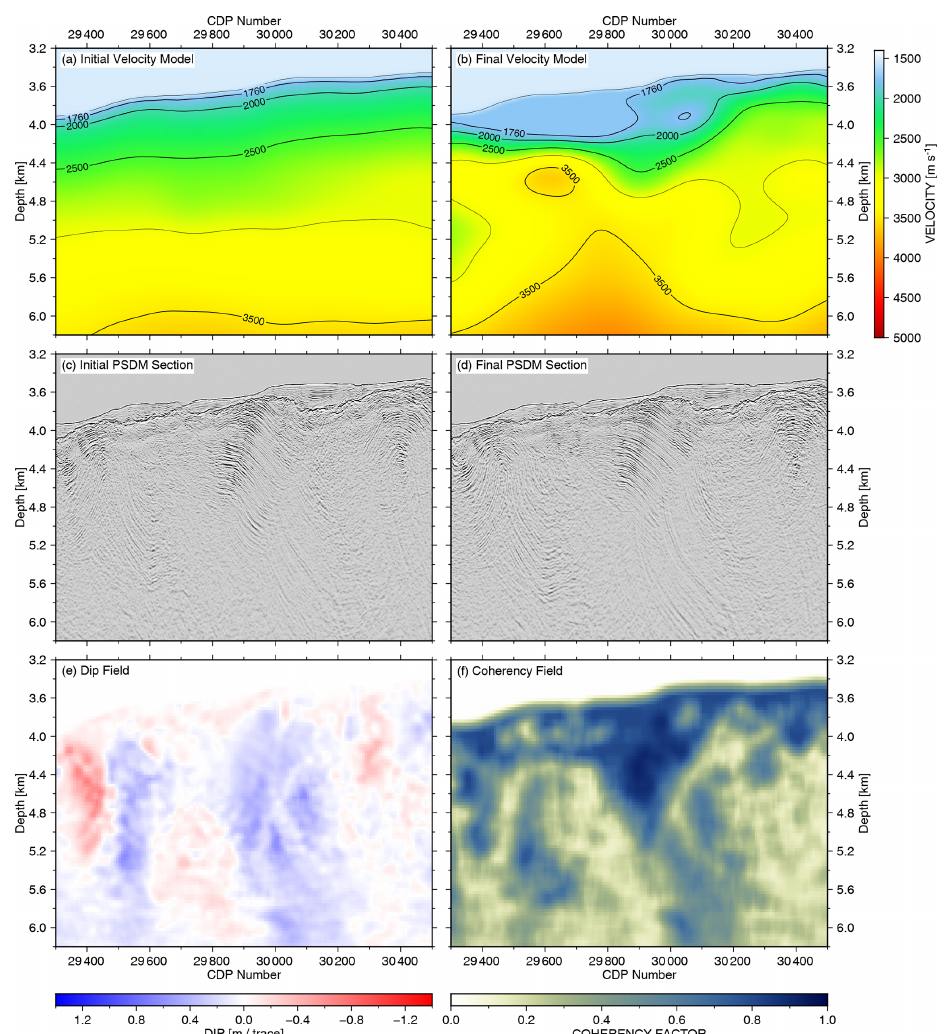
Figure 10. Depth tomography example B in Figs. 5 and 9b, with CDP ranging from 29300 to 30500. (a) Initial velocity model merged from velocity analysis and wide-angle refraction tomography. (b) Final velocity model after five iterations of NRM-based depth tomography and PSDM. (c) PSDM result based on the initial velocity model. (d) PSDM result based on the final velocity model. (e) Reflector dip field calculated from the final PSDM result. (f) Reflector coherency field calculated from the final PSDM result. Notice the continuity and reflector dip change of the folded sediment layers at a depth of 4.0–4.8km in (c) and (d) based on the change of the initial velocity and final velocity (a) and (b) ,